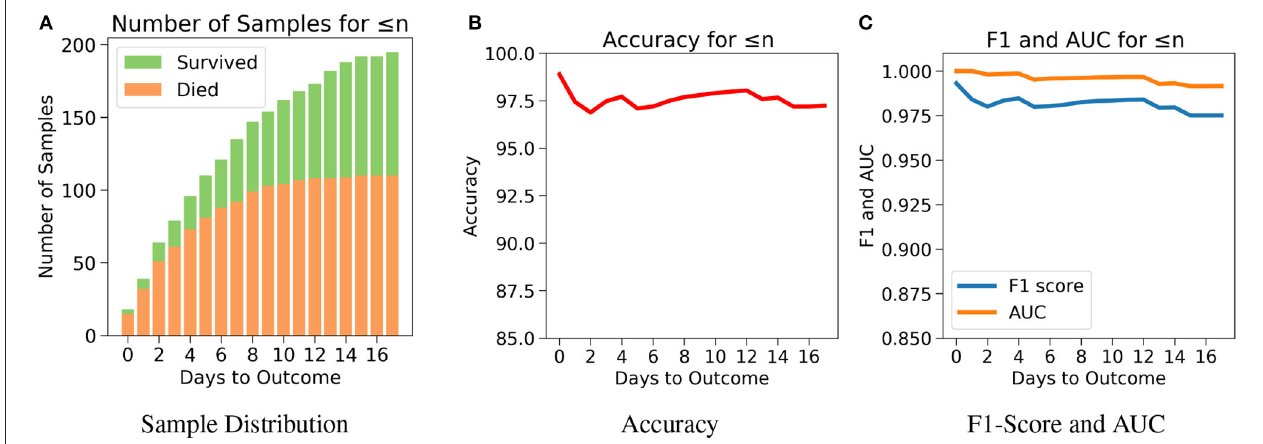
FIGURE 5 | The performance of neural net on the test data using case 1: Number of days to outcome less than or equal to n . (A) The class-wise distribution of the cumulated data-points ( ≤ nth day) for all samples in the imputed test set. (B) Accuracy of the model evaluated for different days to outcome. (C) F1-score and AUC of the model evaluated for different days to outcome.